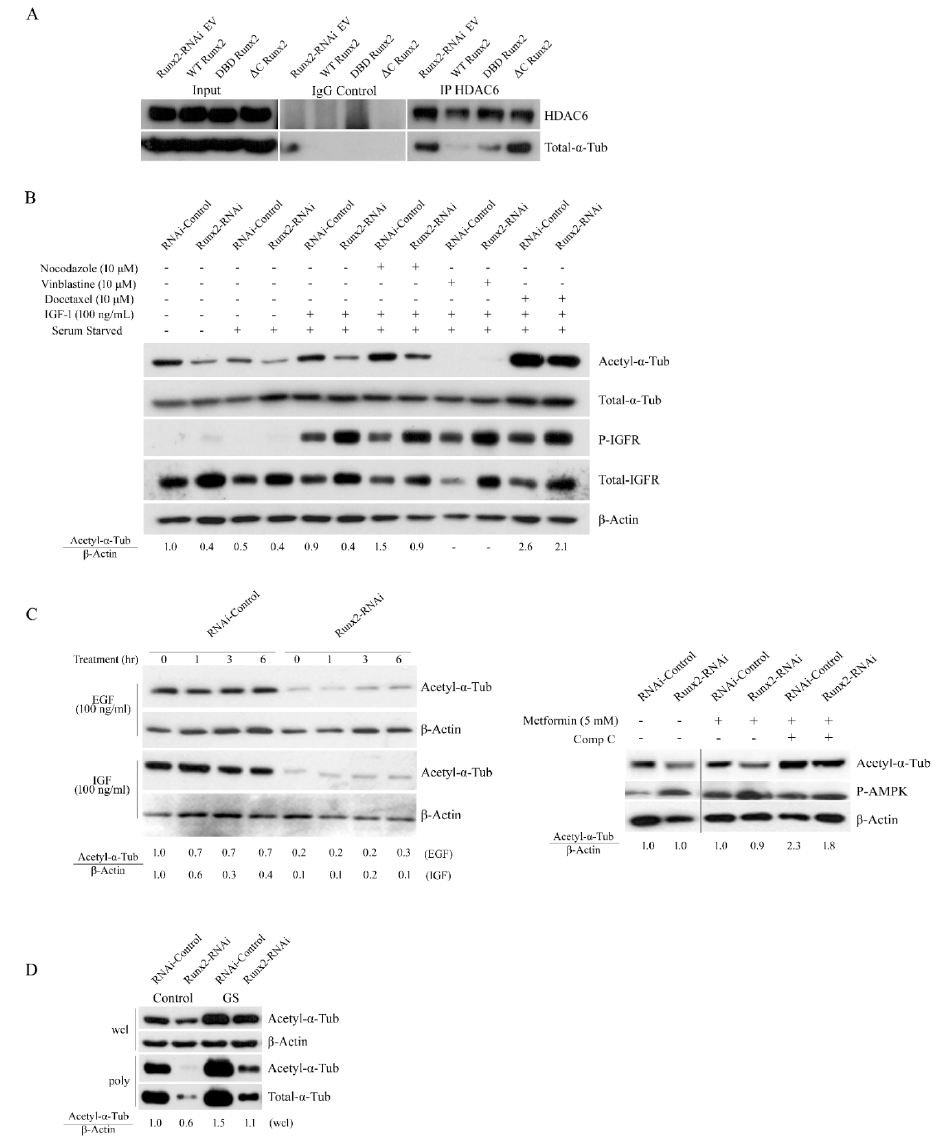
Figure 6. Runx2 inhibits HDAC6 interaction with α -tubulin. ( A ) Runx2 C-terminal suppresses the interaction of HDAC6 and α -tubulin. Input lysates from transduced BoM-MDA-231 Runx2-RNAi cells were collected followed by co-immunoprecipitation with either anti HDAC6 or control rabbit IgG. The resulting pellets were then blotted for HDAC6 and α -tubulin. ( B ) Western blot analysis for acetylated α -tubulin, total α -tubulin, phosphorylated IGF-1R, and total IGF-1R levels in whole-cell lysates from BoM-MDA-231 control and Runx2 knockdown cells treated with nocodazole, vinblastine, and docetaxel for 3 h followed by 3 h of washout. Cells were treated with IGF for 30 min before sample collection. The β -actin expression is shown as an internal loading control. ( C ) Western blot analysis of α -tubulin acetylation levels in BoM-MDA-231 and Runx2 knockdown cells treated with EGF (100 ng/mL) and IGF (100 ng/mL) for 0, 1, 3, and 6 h. The lower panel shows α -tubulin acetylation levels in cells that were treated with metformin (5 mM) or AMPK inhibitor compound C (5 µ M) for 6 h. ( D ) α -tubulin acetylation and total tubulin levels in whole-cell lysates (wcl) and polymer mass (poly) of microtubules isolated from BoM-MDA-231 control and Runx2-RNAi cells. These cells were subjected to complete withdrawal of glucose (3 h) along with a parallel-group in which glucose was replenished (3 h) following withdrawal. Western blots shown are representative of 3 independent